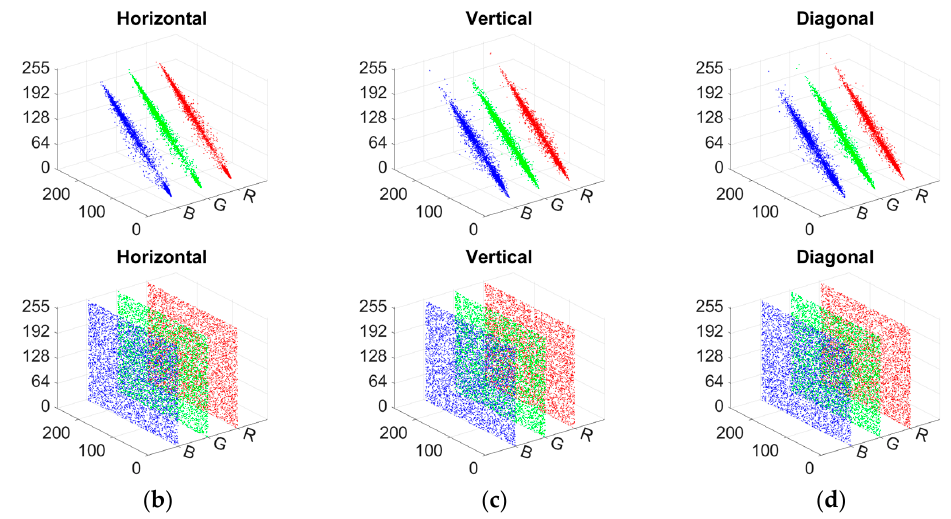
× × with their encrypted versions and with their encrypted versions and